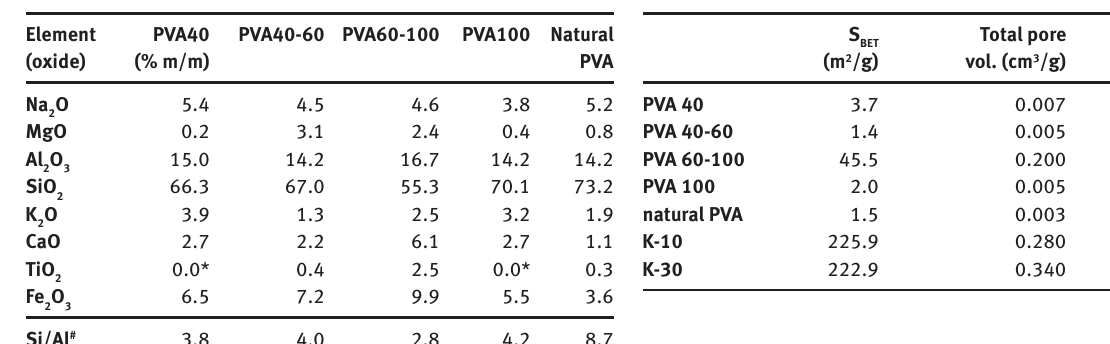
Table 2: BET and pore data for different fractions of volcanic ashes. Table 1 : EDS chemical data for the studied ashes and K-materials.